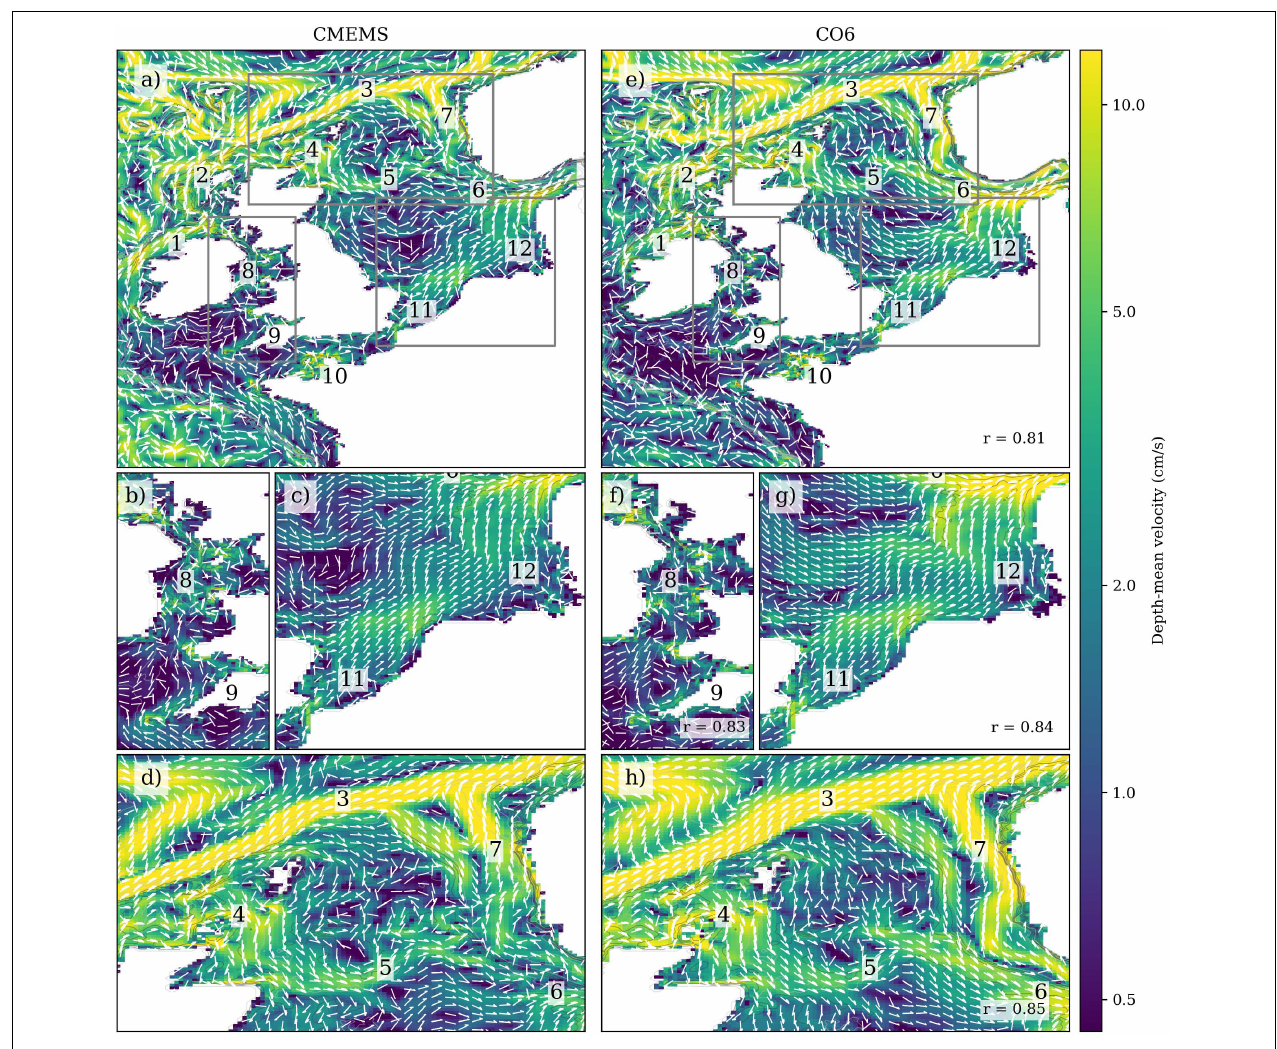
FIGURE 8 | Depth averaged winter mean (2010/2011 and 2011/2012) currents for CMEMS and CO6. See Figure 2 for details, and Box 1 for the numbered circulation features. The spatial correlation of the depth mean current magnitude between each pair of panels is given in (e–h) . This is only calculated from grid boxes within each panel, that are within the NWS. Note the CO6 central North Sea circulation (panel e ) is close to the CMEMS climatology in Figure 2a